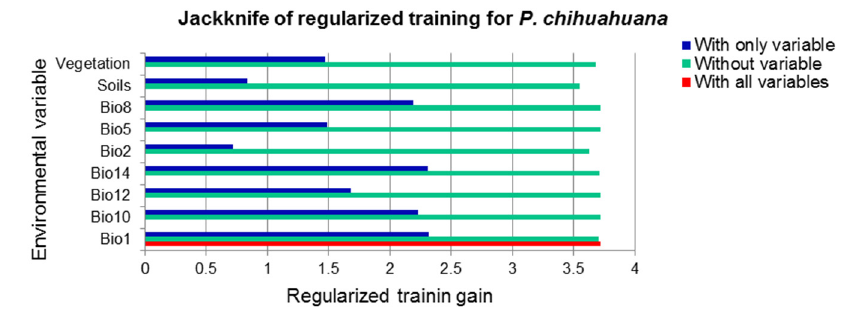
Figure 7. Jackknife of regularized training gain for Picea chihuahuana Martínez at state scale (Chihuahua, Mexico). Bio1 = Annual Mean Temperature, Bio2 = Mean Diurnal Range (Mean of monthly (max temp – min temp)), Bio5 = Max Temperature of Warmest Month, Bio8 = Mean Temperature of Wettest Quarter, Bio10 = Mean Temperature of Warmest Quarter, Bio12 = Annual Precipitation and Bio14 = Precipitation of Driest Month.